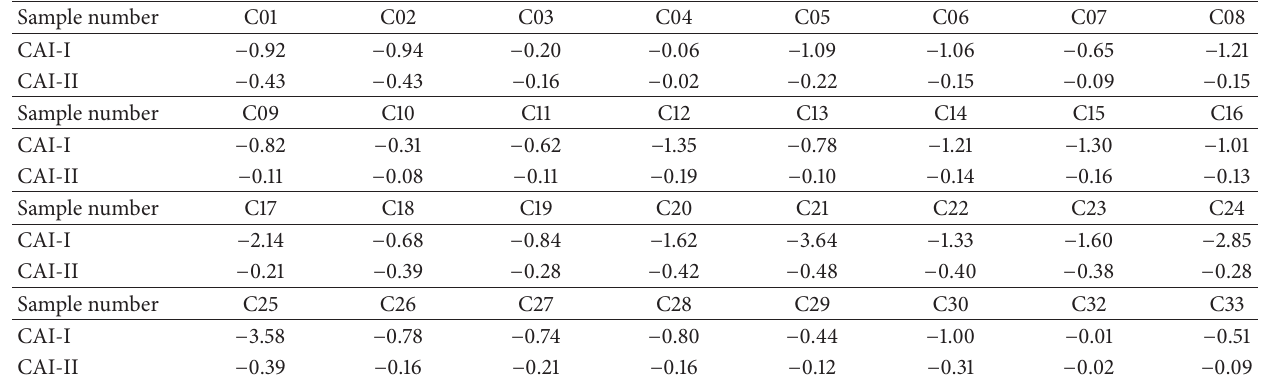
Table 3: Schoeller index values of all samples.